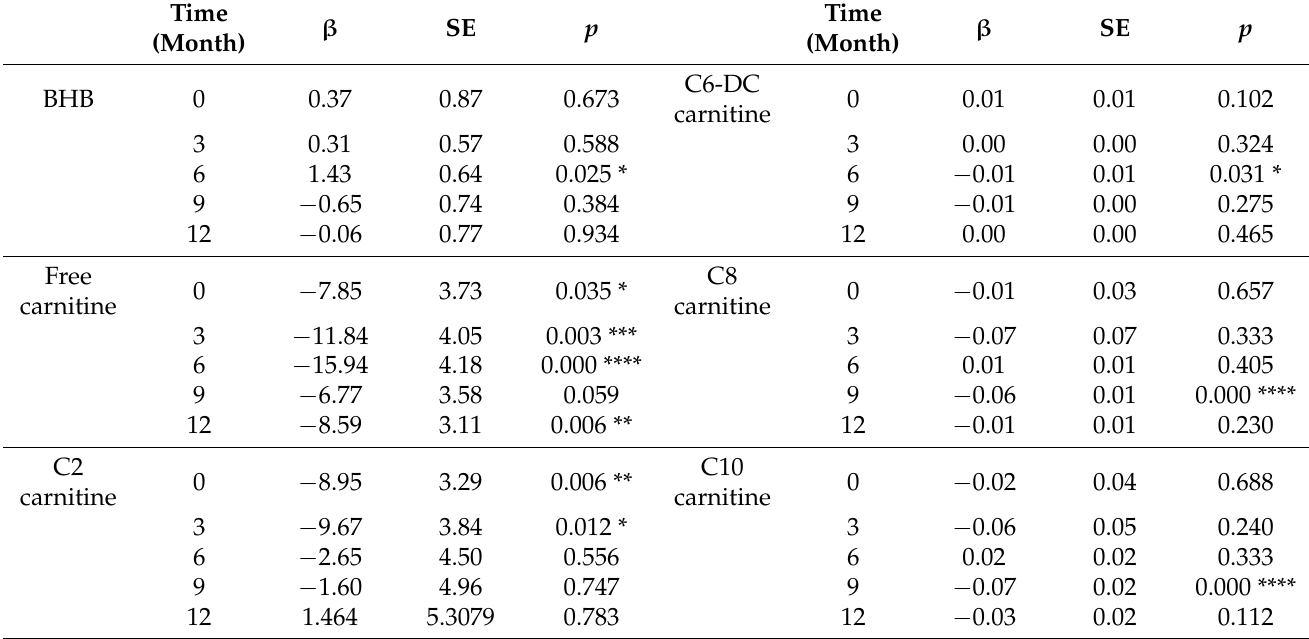
Table 2. Comparison of fatty acid acylcarnitines between responders and non-responders. Acylcarnitines profile of responders ( n = 12) and non-responders ( n = 10). Group differences were analyzed by conducting generalized estimating equation (GEE) after adjusting confounding effect of anticonvulsants. R : responders; NR :